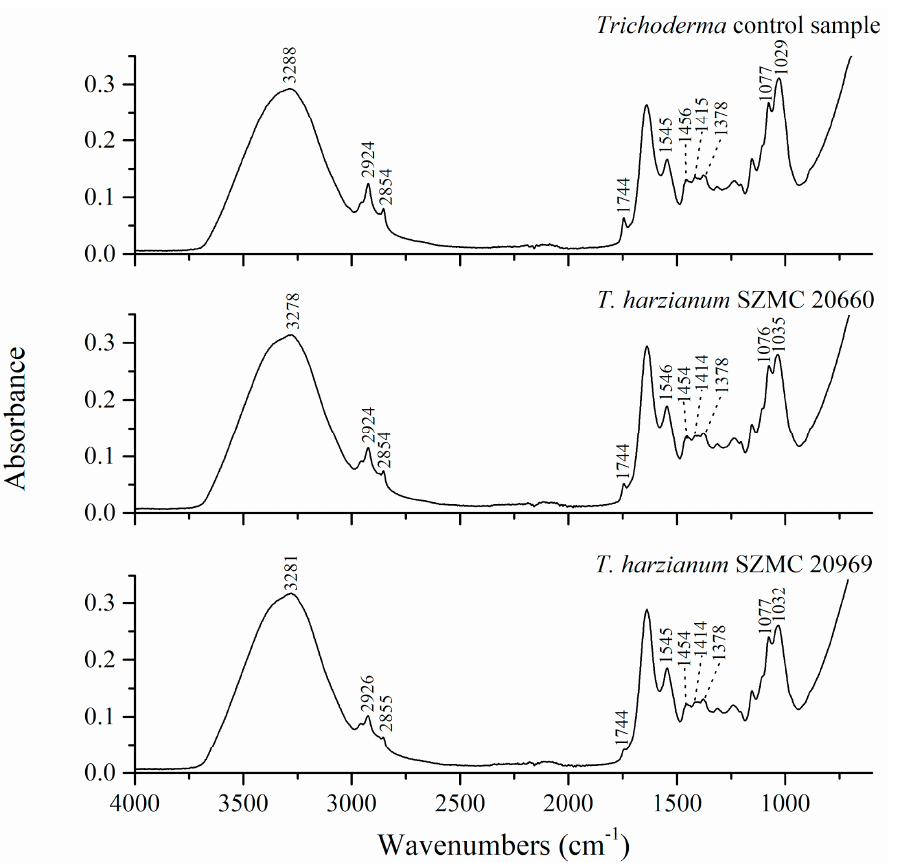
Figure 3. Stacked FTIR spectra of Trichoderma control cell group and strains 20660 and 20969 grown in 60 mg/L PDA medium of Cu.